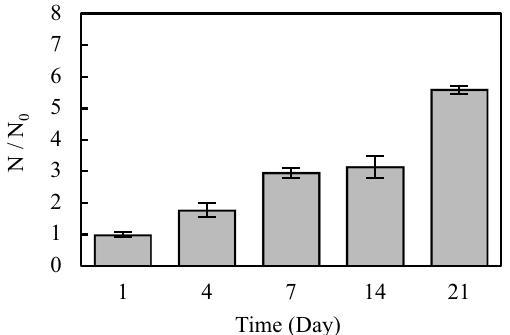
Figure 6. The proliferation rate of normal human chondrocytes on the cartilage (gelatin/elastin/sodium hyaluronate) constructs. N number of cells at each time point, N 0 initial number of the cells.